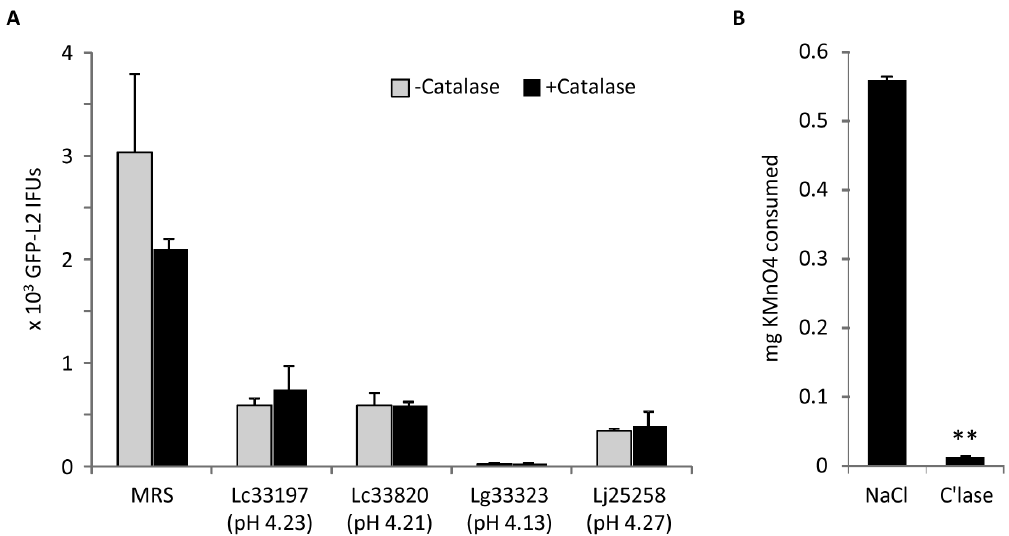
Figure 5. Lack of an effect of catalase on LCM-mediated chlamydiacidal activity. (A) LCM collected from still cultures of Lactobacillus strains were either untreated or treated with catalase before they were used to treat GFP-L2 EBs for 1 h. Surviving bacteria were quantified as outlined in Fig. 1 legend. Values were averages 6 standard deviations of triplicate experiments. Note no statistical differences existed between catalase-treated and untreated samples for LCM from any of Lactobacillus strains. (B) 0.3% H 2 O 2 prepared in 0.17 M lactate-NaOH (pH 4.0) was treated with 0.2 mg/ml catalase or control 0.9% NaCl. Remaining H 2 O 2 was detected with KMnO 4 titration. Values were averages 6 standard deviations of triplicate experiments. Double asterisks signify statistically significant difference (P , 0.01) in the amounts of H 2 O 2 between catalase-treated and non-treated samples, and indicate that the catalase degraded H 2 O 2 in the acidic LCM used in (A).